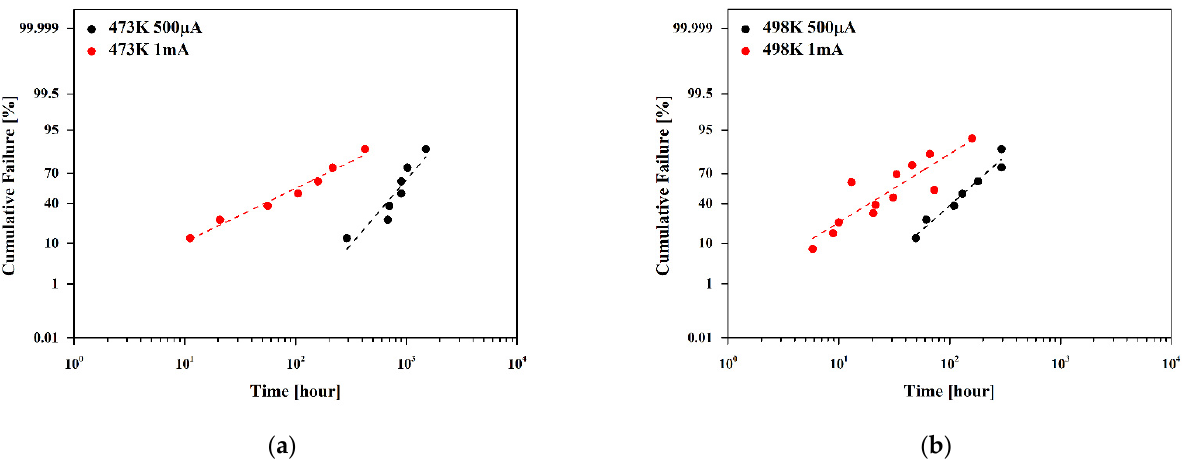
Figure 10. Lognormal projection of the mean time-to-failure versus the percent of cumulative failures for a 10 Gbps planar InGaAs/InP APD after the ALT experiment at ( a ) 473 K and ( b ) 498 K.